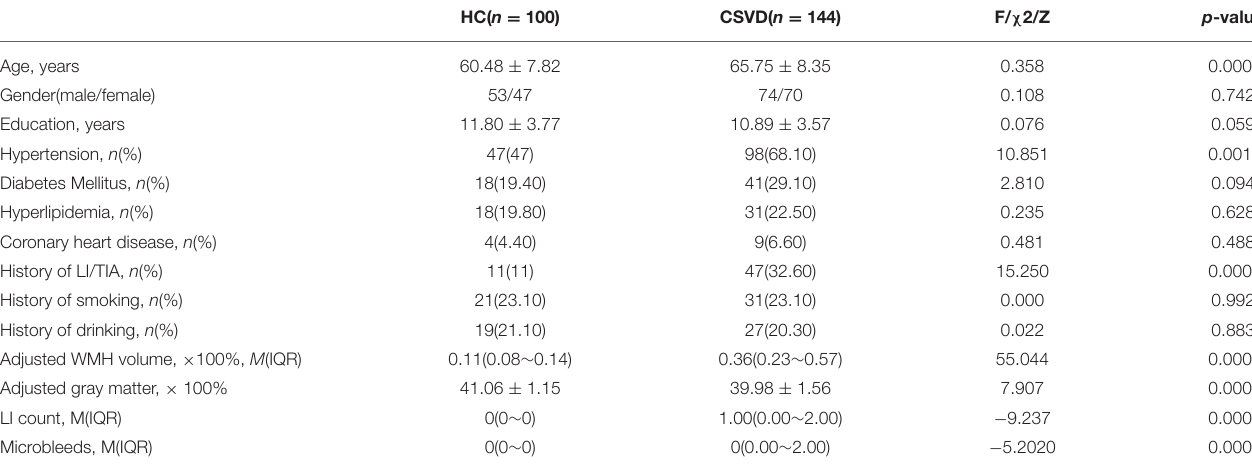
TABLE 2 | Demographic and clinical characteristics.